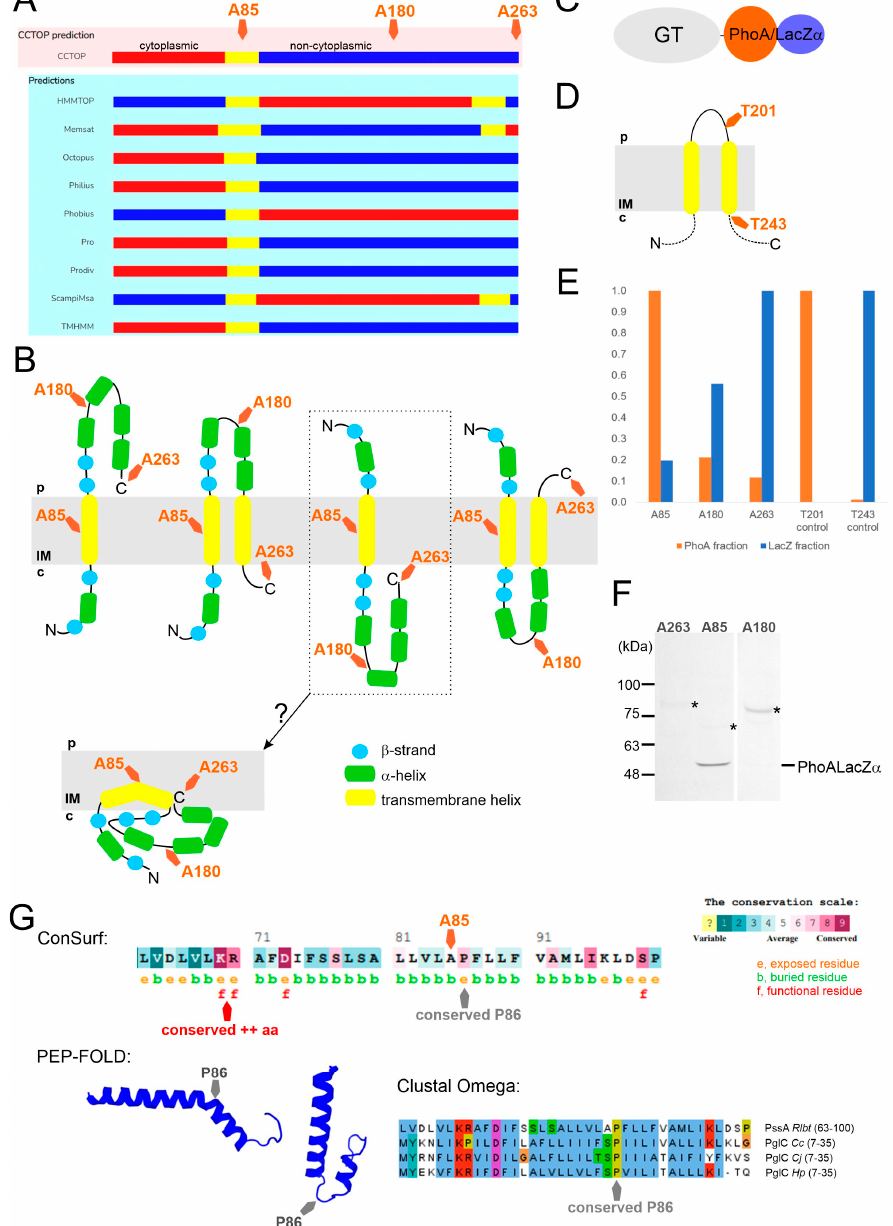
Figure 2. PssA phosphoglycosyl transferase topology prediction, analyses, and modelling. ( A ) Graphical presentation of CCTOP meta-tool topology predictions being the result of consensus for ten different methods. ( B ) Four possible topology models resulting from combined CCTOP and Phyre2 predictions; dotted frame surrounds the only bitopic model partially supported by the bio- chemical data, and further elaborated based on the analyses summarized in panel G. ( C ) Schematic representation of dual reporter translational fusions construction. ( D ) Schematic representation of PssT control periplasmic and cytoplasmic fusions construction; dotted lines indicate that the scheme presents only a fragment of this 12-TMS-protein. ( E ) Reporter enzymes activity quantification—the graph presents relative values, i.e., the percentage of PhoA and LacZ activities of the fusions regard- ing the maximum activity in the set for PssA and PssT alone. ( F ) Western blotting result showing the level of expression and stability of PssA fusion proteins; bands marked with asterisks represent PssA fusion proteins with predicted molecular masses: A85—64.4 kDa, A180—74.8 kDa, and